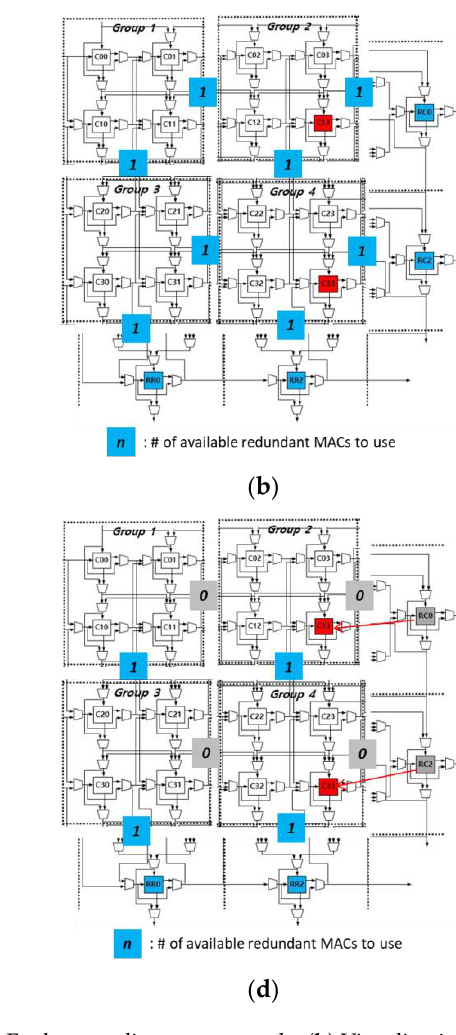
Figure 5. Example of the proposed repair strategy: ( a ) Faulty systolic-array example; ( b ) Visualization of the number of available redundant MACs of each group; ( c ) Repair decision of C13; ( d ) Repair decision of C33.